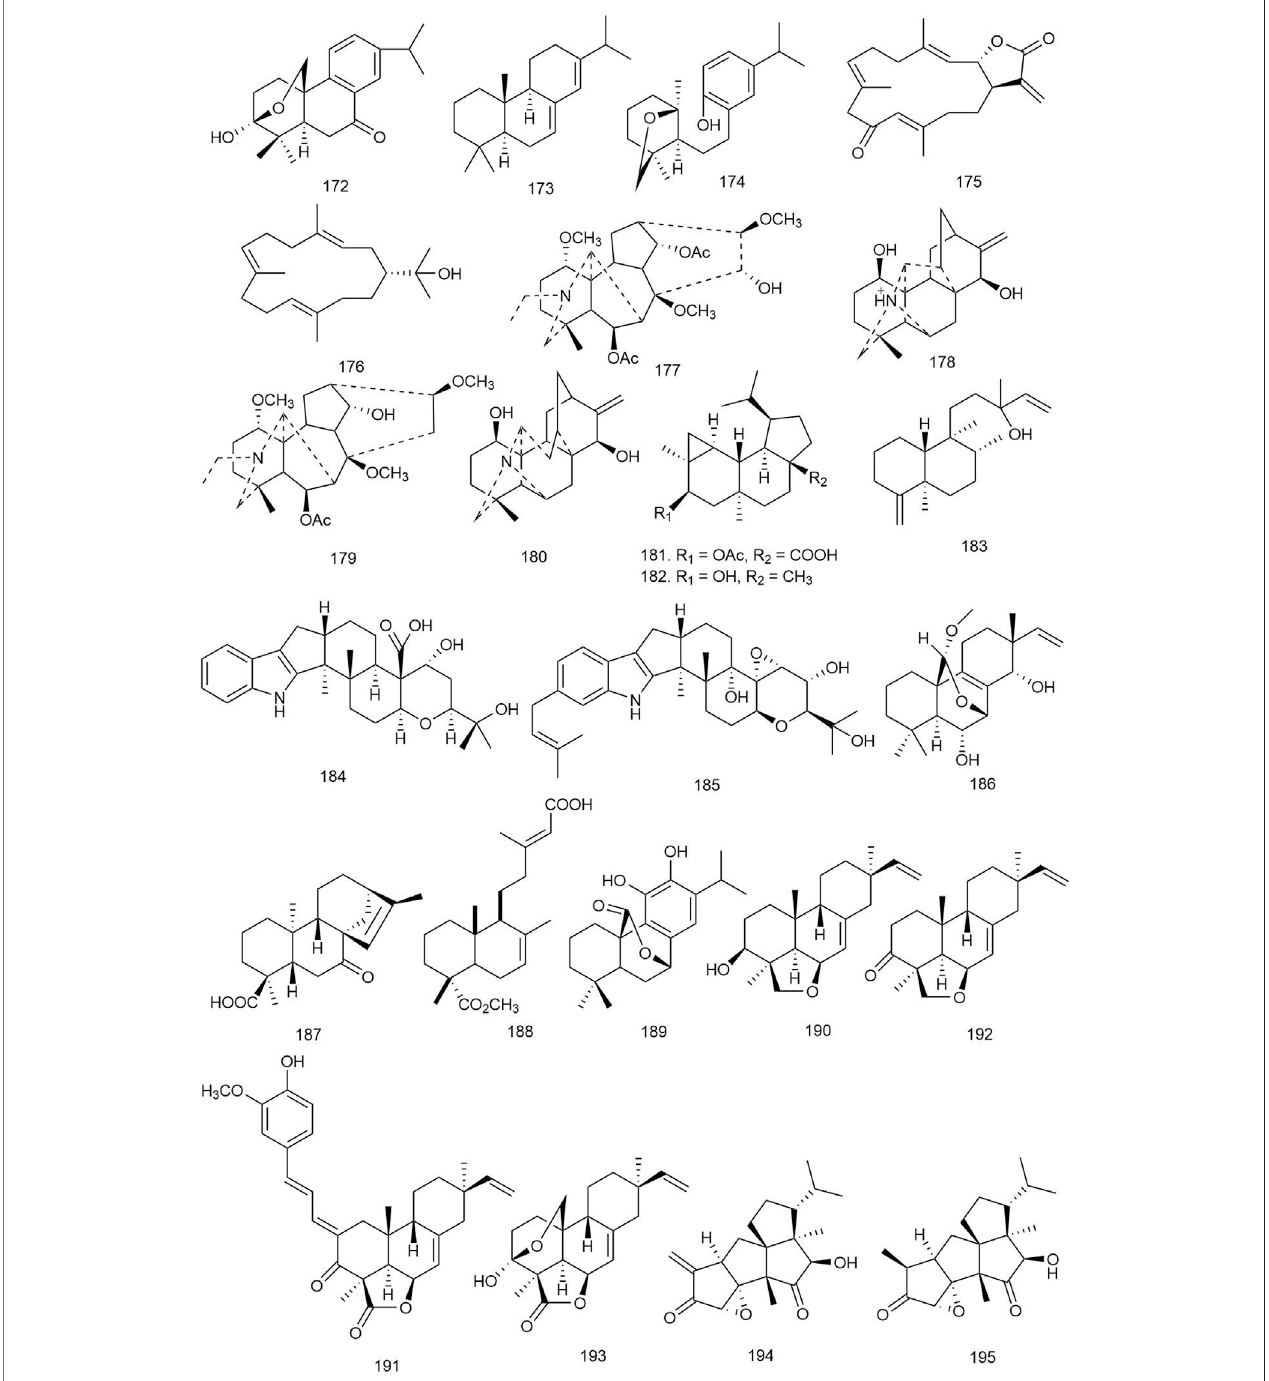
FIGURE 10 | Structures of abietane, cembrane, diterpenoid alkaloids, epi-neoverrucosane, indole, isopimarane, kaurene, labdane, phenolic, pimarane, tetraquinane, and miscellaneous diterpenoids with signi fi cant antifungal activity.